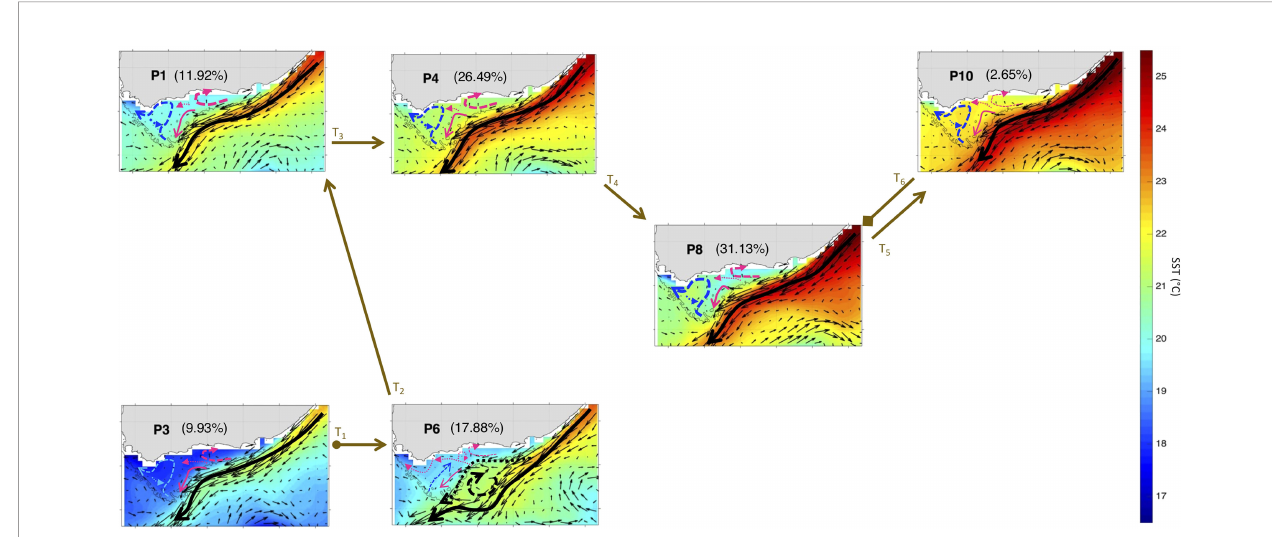
FIGURE 10 | Same as Figure 3 but for Nov-Mar 2005-06. The frequency of occurrence of each pattern is calculated here relative to the days recorded during Nov- Mar 2005-06. The brown arrows represent the SOM patterns trajectories (T i=1:6 ) evolving during Nov-Mar 2005-06 as inferred from the BMU timeseries ( Supplementary Figure 4A ). The starting ( fi nal) trajectory is designated with a circle (diamond) at the arrow beginning (end).